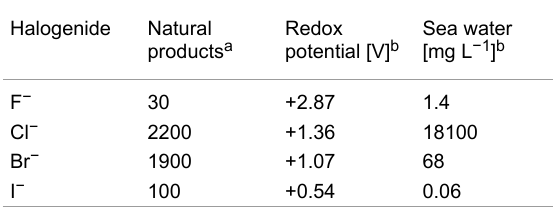
Table 1: Approximate number of known halogenated natural products and redox potential and natural abundance of the halogenides in sea